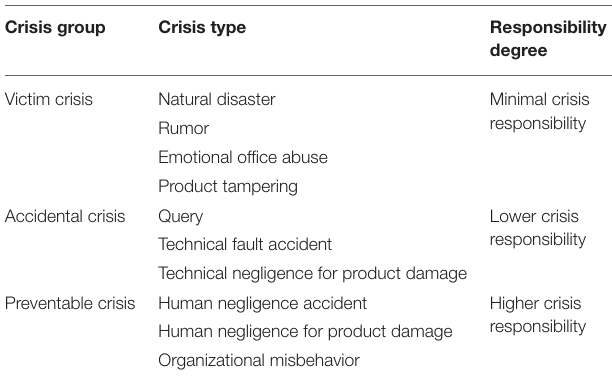
TABLE 3 | Classification of crisis types in